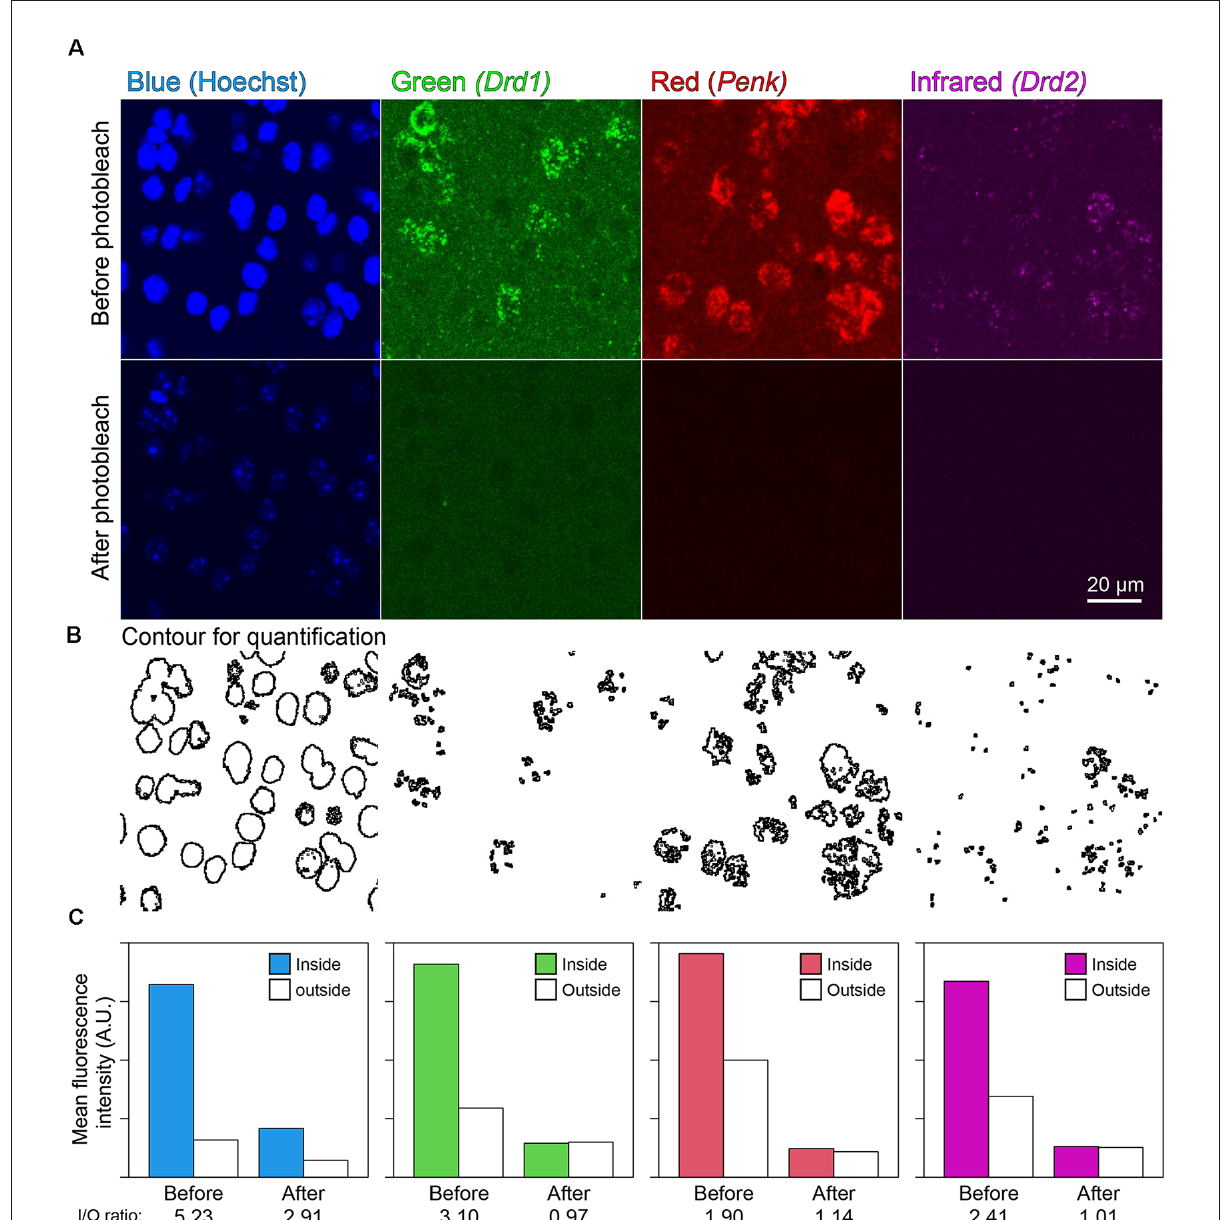
FIGURE4 Effect of photobleaching on the fluorescence of ISH-HCR. (A) Mouse striatal tissue stained with Drd1 , Penk , and Drd2 mRNA in addition to Hoechst 33342 nuclear staining. The upper panels show confocal images before photobleaching, and the lower panels show confocal images in the same location after photobleaching. Scale bar: 20 µ m. (B) Contour for quantification of signal to background ratio change shown in (C) . (C) Bar plots show mean fluorescence intensity inside or outside the contour. The inside/outside ratio of fluorescence intensity are shown at bottom